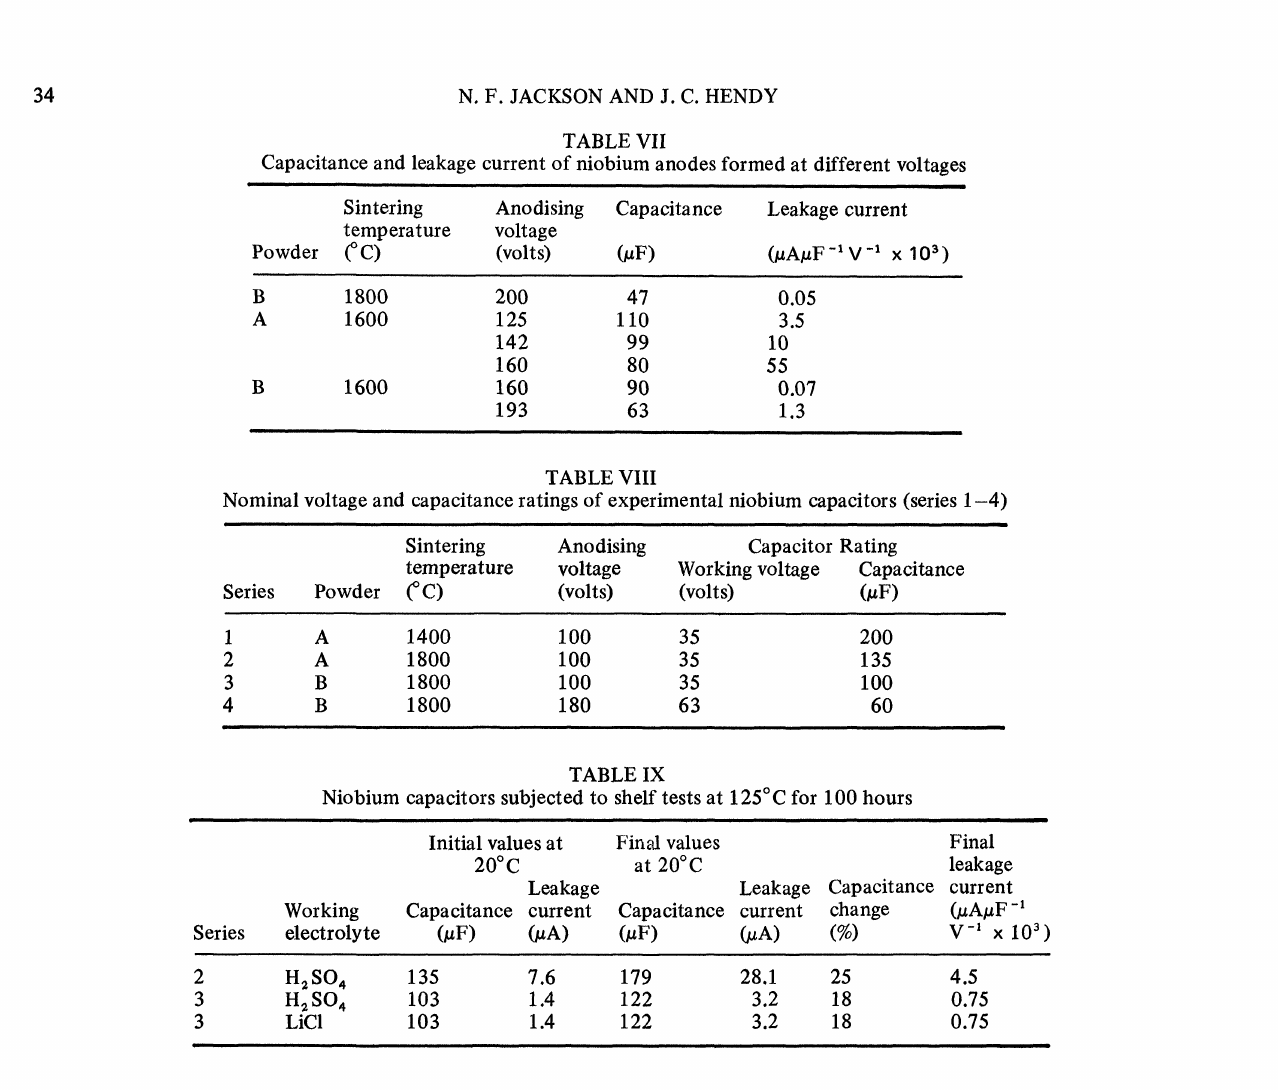
TABLE IX Niobium capacitors subjected to shelf tests at 125 C for 100